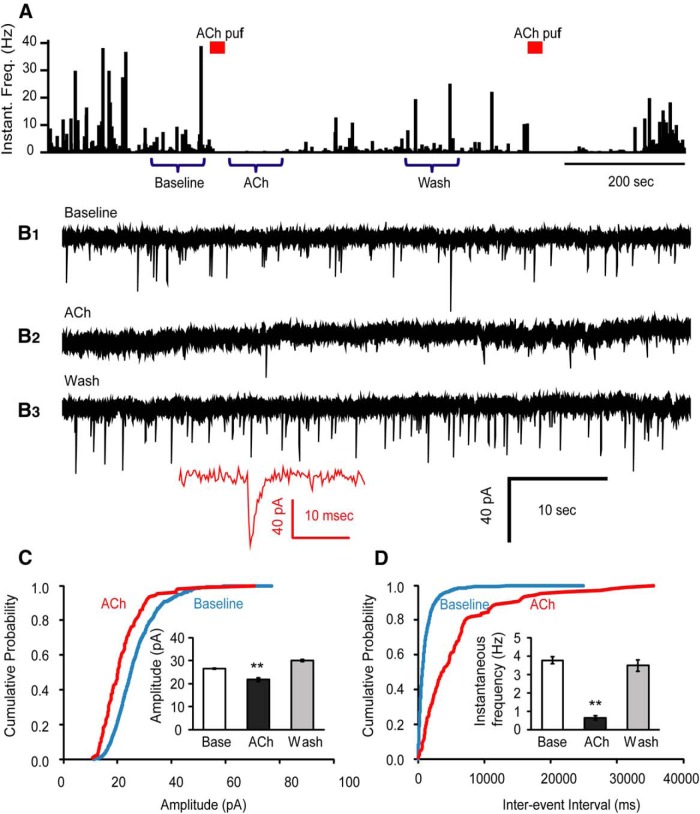
ACh suppresses glutamatergic spontaneous mEPSCs onto Hcrt+ neurons in the presence of atropine. A, Histograms of mEPSC instantaneous frequency show the time course of the effect of ACh on glutamatergic mEPSCs from synapses impinging onto Hcrt+ neurons. Bars above the graph indicate the time point of the ACh (1 mM) puff. The original recordings indicated by “Baseline”, “Ach”, and “Wash” are displayed in B1, B2, and B3, respectively. Inset shows the full trace of an example mEPSC event. C, Cumulative probability plot of the mEPSC amplitude at baseline and upon ACh application from six cells. Inset shows the mean value of the mEPSC amplitude at three time periods: baseline, under the influence of ACh, and washout. **p < 0.01. D, Interevent intervals of mEPSCs at baseline and upon ACh application from six cells (same cells as in C). Inset shows the mean of instantaneous frequency of the mEPSC at three periods of time: baseline, under the influence of ACh, and after washout.